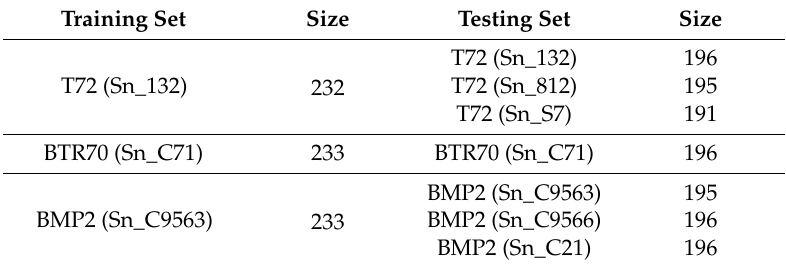
Table 1. Training and testing set of SAR images for the three-target problem. Training Set Size Testing Set